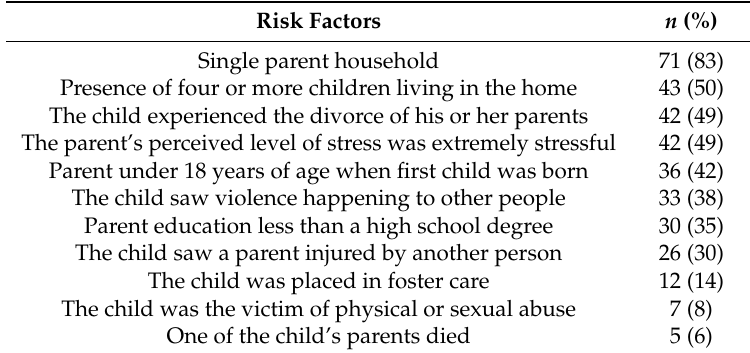
Table 2. Adverse Childhood Experiences and Sociodemographic Variables Included in Cumulative Risk